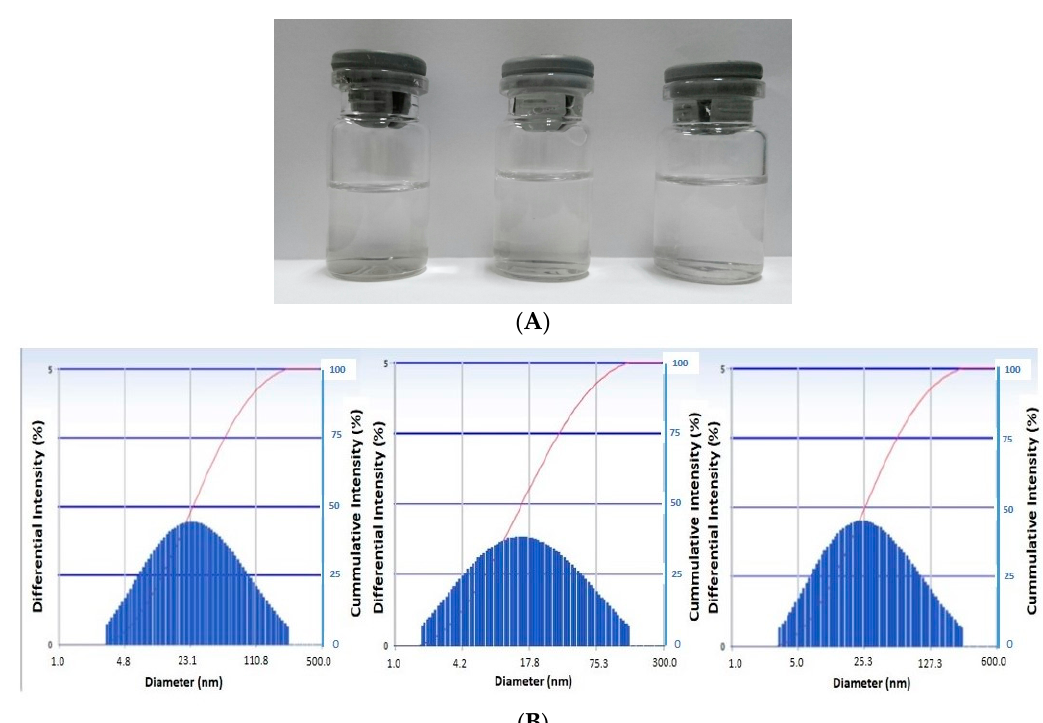
Figure 2. Visual appearance ( A ) and globule size distribution ( B ) of blank nanoemulsion after nine months storage at room temperature.